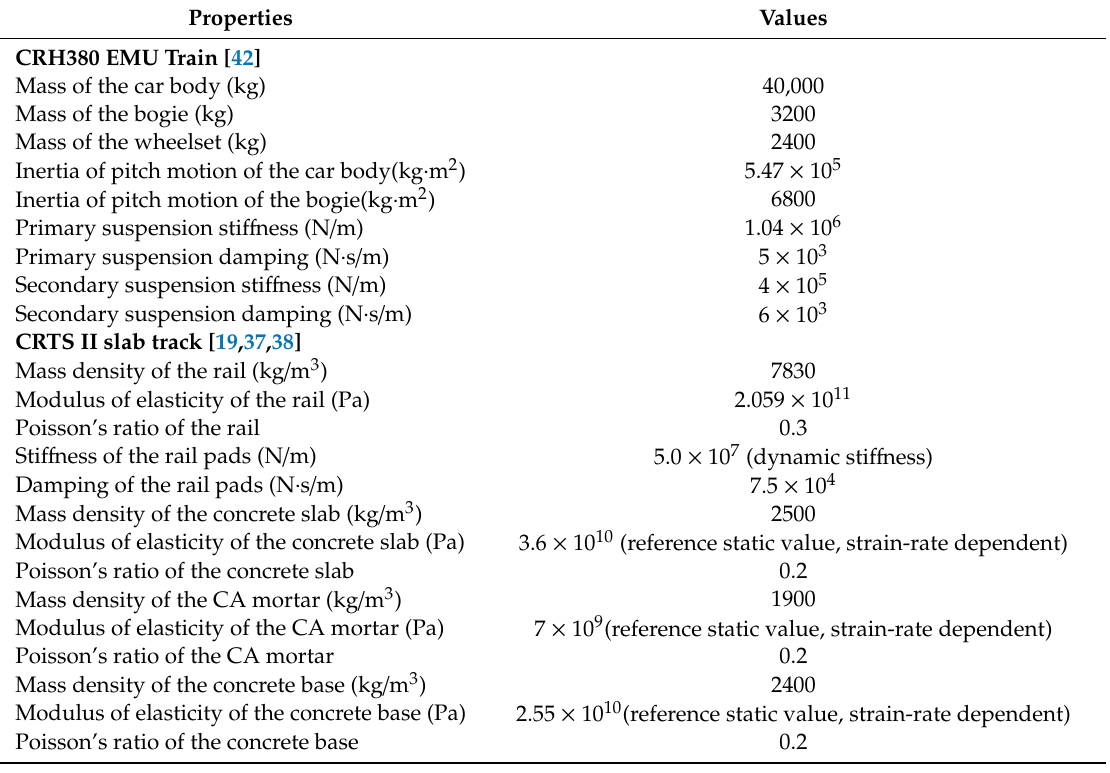
Table 1. Properties of the vehicle and slab track; CRH380 EMU = China Railway High-speed (CRH) 380 Electric Multiple Unit; CRTS = China Railway Track System; CA = cement asphalt.